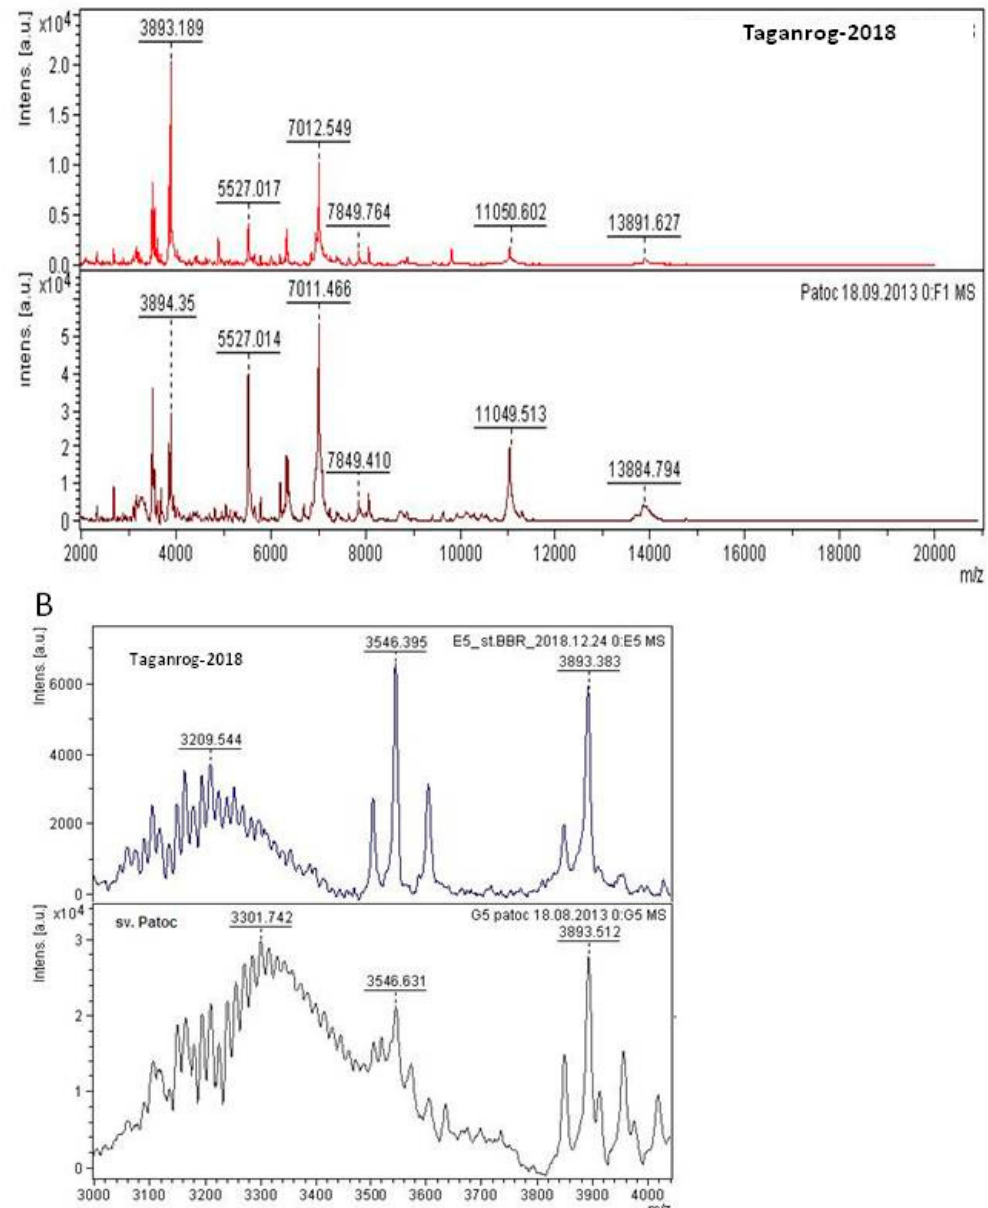
Figure 2. MALDI-TOF spectra of the studied isolate Taganrog - 2018 and the reference strain of L. biflexa Patoc I serovar Patoc. ( A ) Mass peaks in the molecular weight range m/z = 2000 – 20000 Da; ( B ) Cluster of peaks in the range m/z=3000 - 3500 Da.